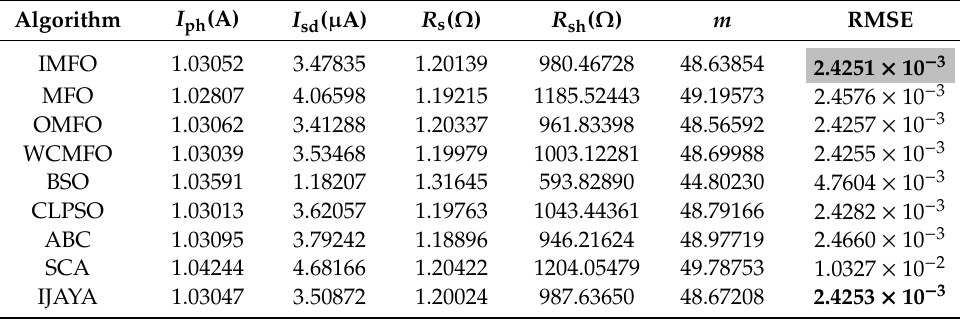
Table 4. Comparison among di ff erent algorithms on the PV module model.